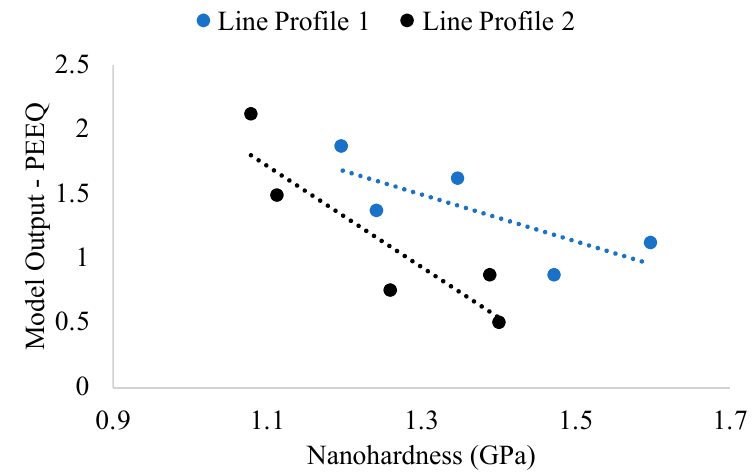
Figure 55. The PEEQ FEA output for the two profiles identified in relevant figures was plotted herein in relation to the nanoindentation hardness recorded. A linear fit was applied to the profiles.